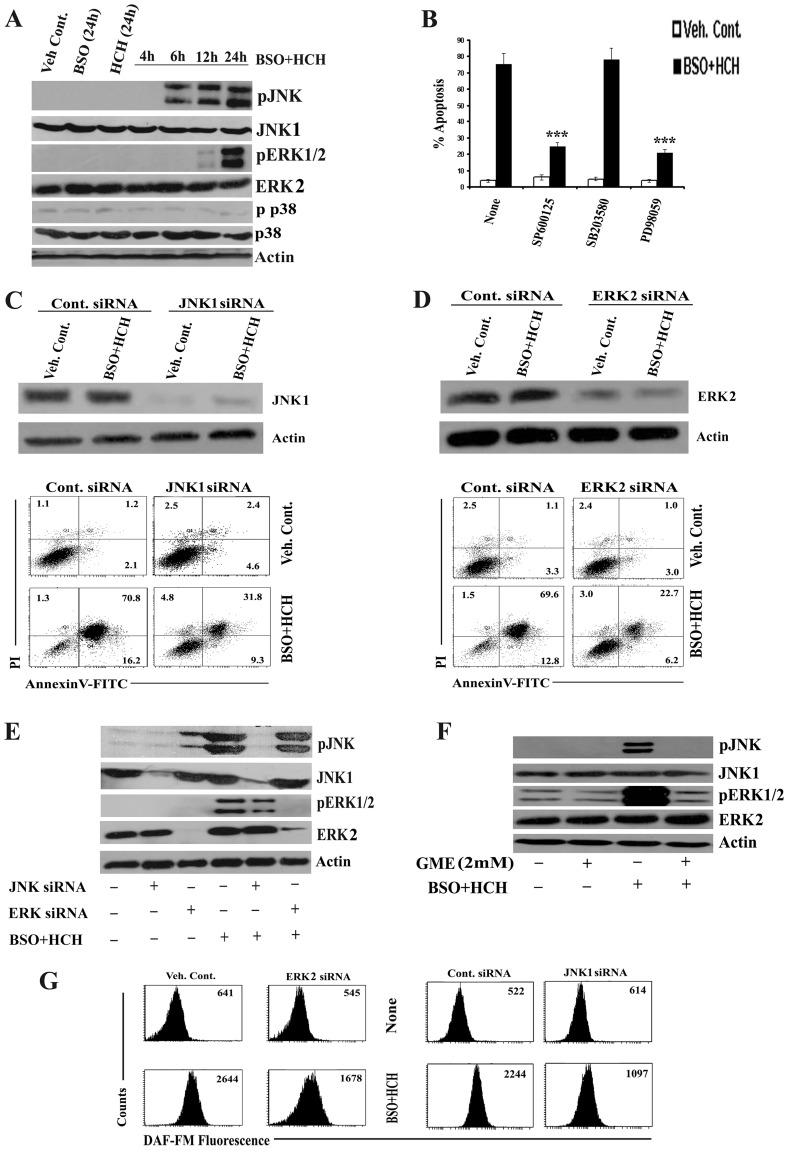
Apoptosis induced by combination of BSO and HCH is mediated by JNK dependent ERK1/2 activation.(A) K562 cells were treated as indicated for different time periods and cell lysates were subjected to western blot analysis with indicated antibodies. (B) K562 cells were pretreated with JNK inhibitor SP600125 (20 µM), p38 inhibitor SB203580 (20 µM), ERK inhibitor PD98059 (40 µM) for 1 h before treatment with BSO (100 µM) and HCH (10 µM) in combination. After 36 h of incubation, cells were subjected to Annexin V/PI binding assay by flow cytometry. Data represent mean ± SD of three experiments. *** p<0.001 compared to treatment in absence of MAPK inhibitors. (C) Knockdown of JNK by specific JNK1 siRNA attenuates apoptosis. JNK1 protein level was shown after knockdown (upper panel). Annexin V/PI binding assay by flow cytometry in K562 cells after transfection with indicated siRNAs (lower panel). Dot plots are representative of two similar experiments. (D) Knockdown of ERK by specific ERK2 siRNA attenuates apoptosis. ERK2 protein level was shown after knockdown (upper panel). Annexin V/PI binding assay by flow cytometry after knocking down ERK2 (lower panel). Dot plots are representative of two similar experiments (E) K562 cells were transfected with indicated siRNAs for 48 h and then treated with BSO plus HCH for 18 h. Protein expression and phosphorylation of JNK and ERK1/2 were analysed by western blot on whole cell lysates. (F) K562 cells were pre-incubated with or without 2 mM GME for 1 h and further incubated with BSO (100 µM) and HCH (10 µM) in combination for 18 h. The level of each protein and phosphorylation status was analyzed as indicated by western blot. (G) K562 cells were transfected with indicated siRNAs for 48 h and then treated with BSO plus HCH for 24 h. Analysis of intracellular NO was done by flow cytometry after staining with DAF-FM. Histograms are representative of two similar experiments.